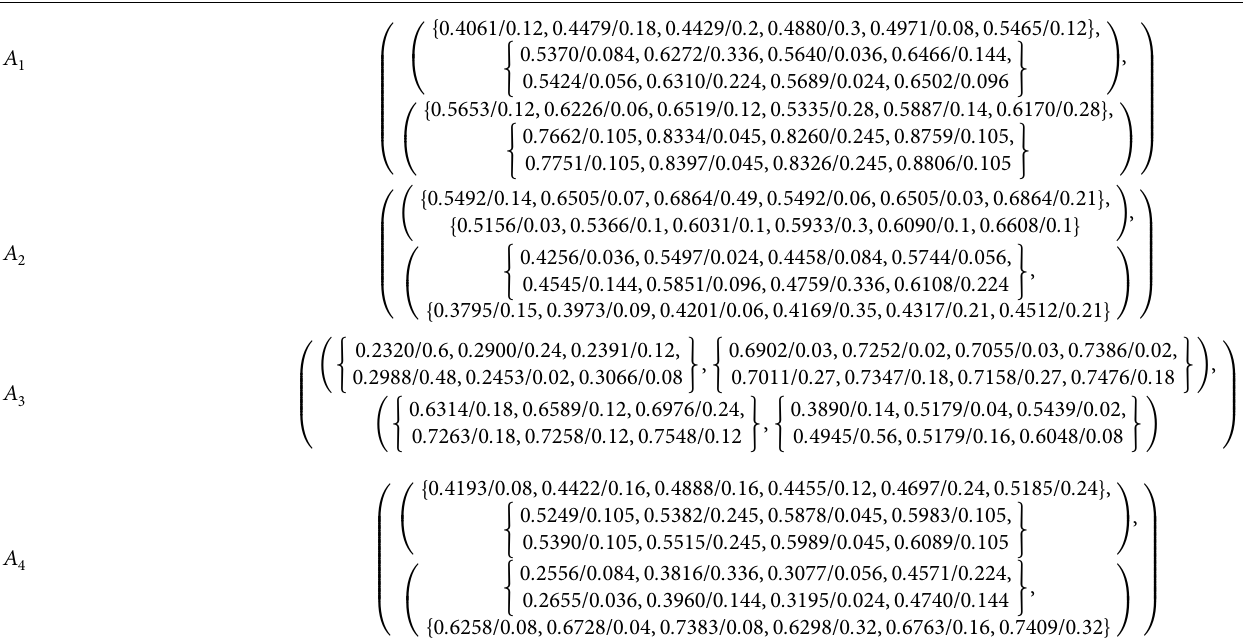
Table 4: Aggregated information using q -ROPHFREWG.